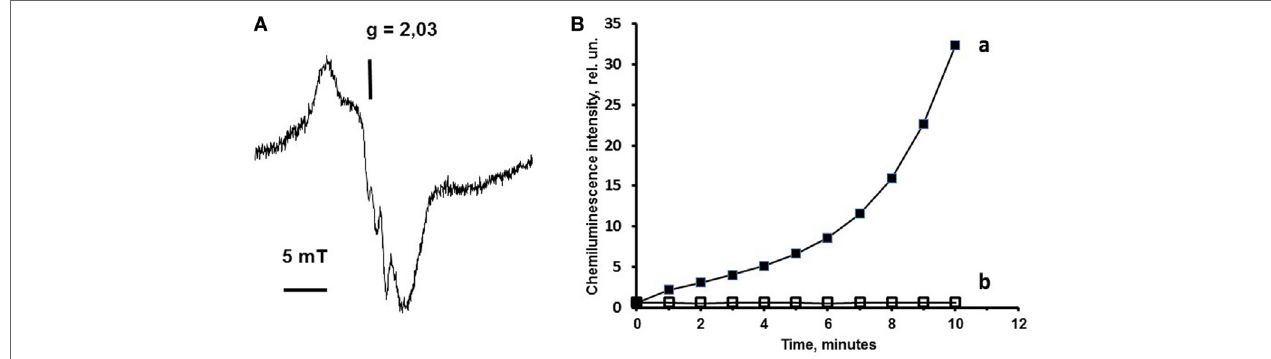
FigURe 2 | Effect of nitric oxide (NO) on cytochrome c properties. The cytochrome c nitrosyl complex formation and inhibition of cytochrome c peroxidase activity by NO is exemplified by the findings previously published elsewhere (20, 21). In panel (A) , a cytochrome c –cardiolipin (CL) nitrosyl complex electron spin resonance (ESR) signal is presented. This signal of cytochrome c nitrosyl complexes has a g factor 2.03 and completely corresponds to nitrosyl complex ESR signal of some hemoproteins. Chemiluminescence assay used in our studies allows to measure the peroxidase activity of cytochrome c in the presence of hydrogen peroxide. In panel (B) , a chemiluminescent kinetic curve is presented to demonstrate the peroxidase activity of cytochrome c –CL complex. (A) ESR spectrum of cytochrome c nitrosyl complexes formed in the presence of CL. Sample content: cytochrome c (50 µM), CL–phosphatidylcholine liposomes (1:1, 0.5 mM), and NO solution in phosphate buffer (0.2 mM). Sample volume 0.5 ml. ESR spectra were recorded at 77 K. (B) Effects of CL on cytochrome c peroxidase activity measured by chemiluminescence. Sample content: (a) cytochrome c (10 µM) + CL–phosphatidylcholine liposomes (1:1, 500 µM); (b) cytochrome c (10 μM) + CL– phosphatidylcholin liposomes (1:1, 500 µM) + NO (0.7 mM). All samples were prepared in 10 mM phosphate buffer (pH 7.4). H 2 O 2 (100 μM) and luminol (500 µM) were added immediately before measurements.